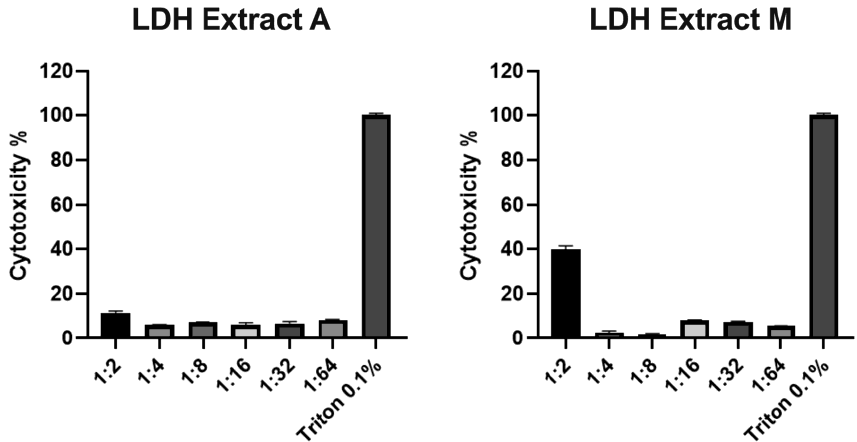
Figure 6. Cell cytotoxicity assay performed by the lactate dehydrogenase (LDH) assay to analyze the effect of different concentrations of N. oleoabundans extract A and M, respectively, obtained from autotrophic (A) and mixotrophic (M) algae cultures, after 24 h treatment on human MRC-5 fibroblast cells. Triton 0.1% was used as positive control for 100% cell death. Values are reported as means ± standard deviations ( n = 3). In each case, p value was always below